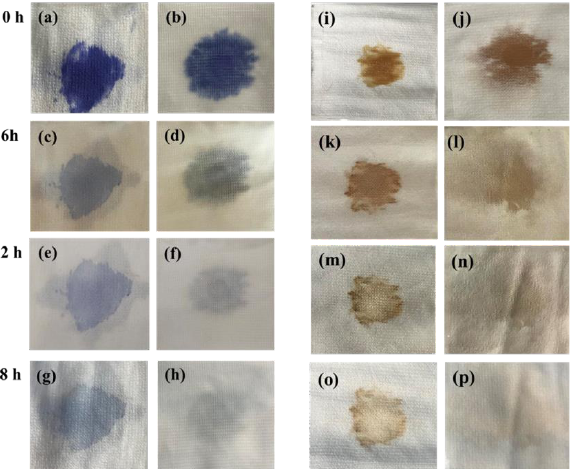
Figure 15. The self-cleaning performance of the Y 2 O 3 /TiO 2 -loaded polyester fabric to methyl blue and soy sauce: ( a , c , e , g ) are polyester fabrics with methyl blue; ( b , d , f , h ) are the polyester fabric with methyl blue and loaded with Y 2 O 3 /TiO 2 ; ( i , k , m , o ) are the polyester fabric with soy sauce; ( j , l , n , p ) are Y 2 O 3 /TiO 2 loaded polyester fabric dripped with soy sauce.